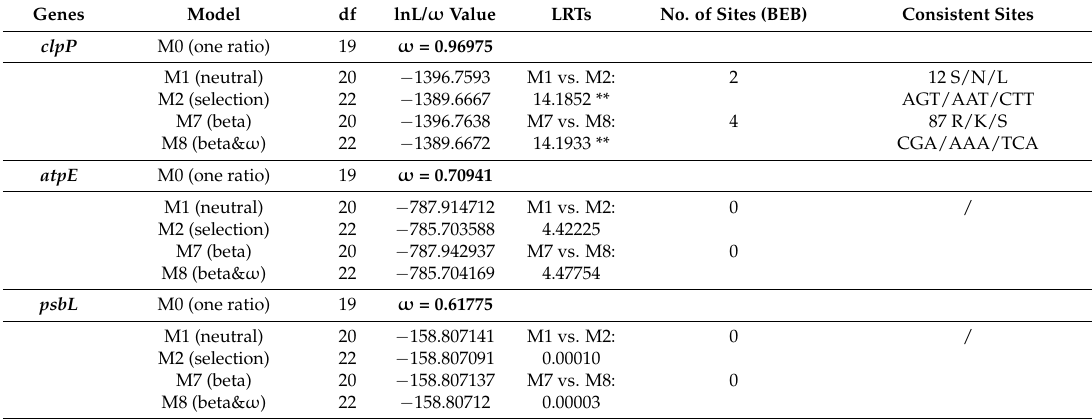
Table 3. Parameter estimates and log ‐ likelihood values for different models in selective pressure Parameter estimates and log-likelihood values for different models in selective analysis. pressure